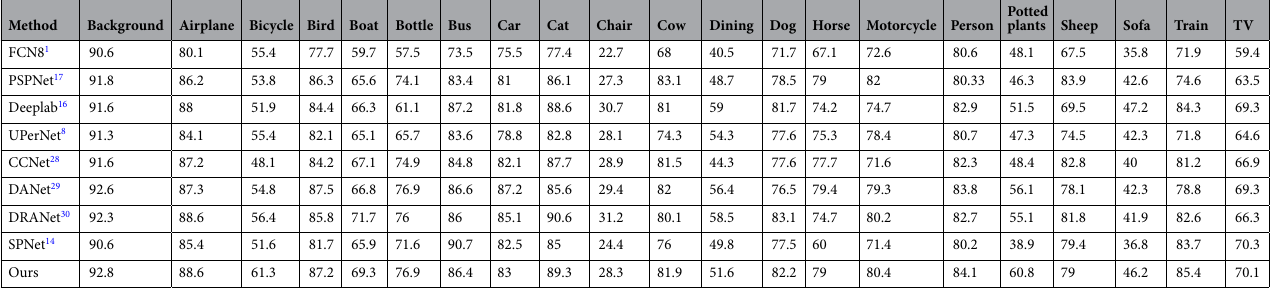
Table 3. Per-class results on PASCAL VOC 2012 (val).